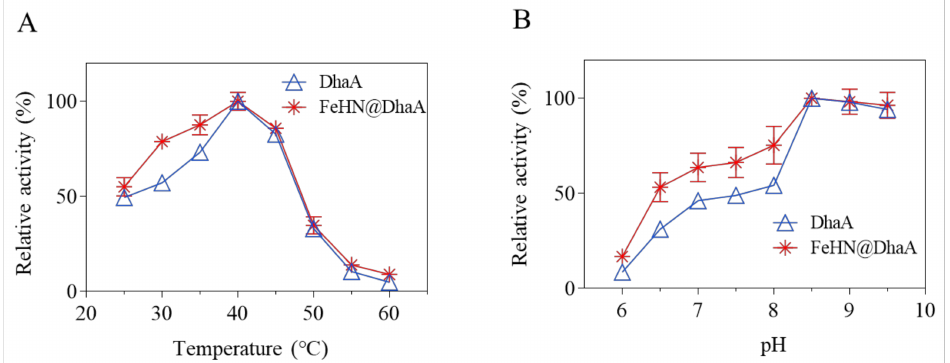
Figure 6. Optimum temperature ( A ) and pH ( B ) of free and immobilized